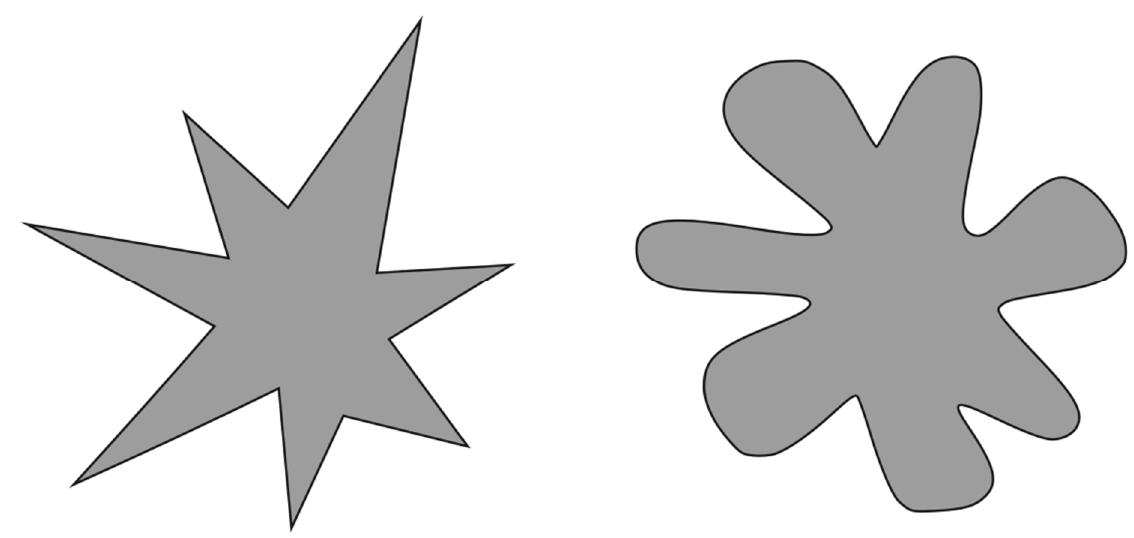
Figure 2. Kiki and